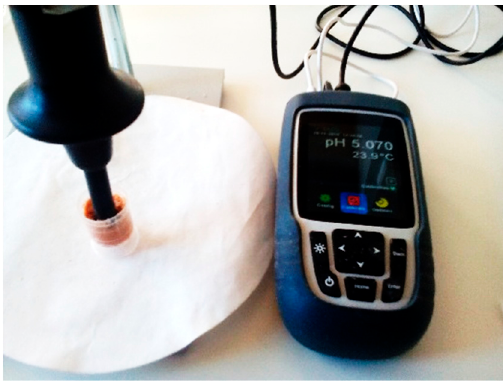
Figure 3. Measuring the pH value using the piercing electrode in sawdust .